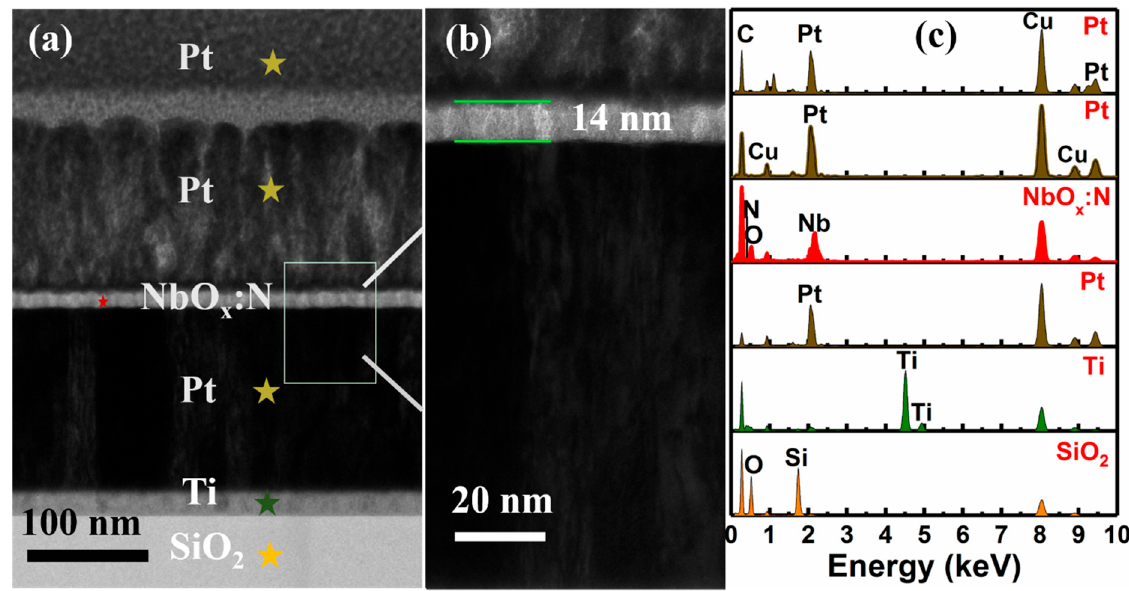
Figure 1. ( a ) Cross-sectional TEM of Si/SiO 2 /Ti/Pt/NbO x :N multi-film; ( b ) enlarged view of the NbO x :N film in a square area of ( a ); ( c ) EDX point scanning of each layer in a pentagram region in ( a ).